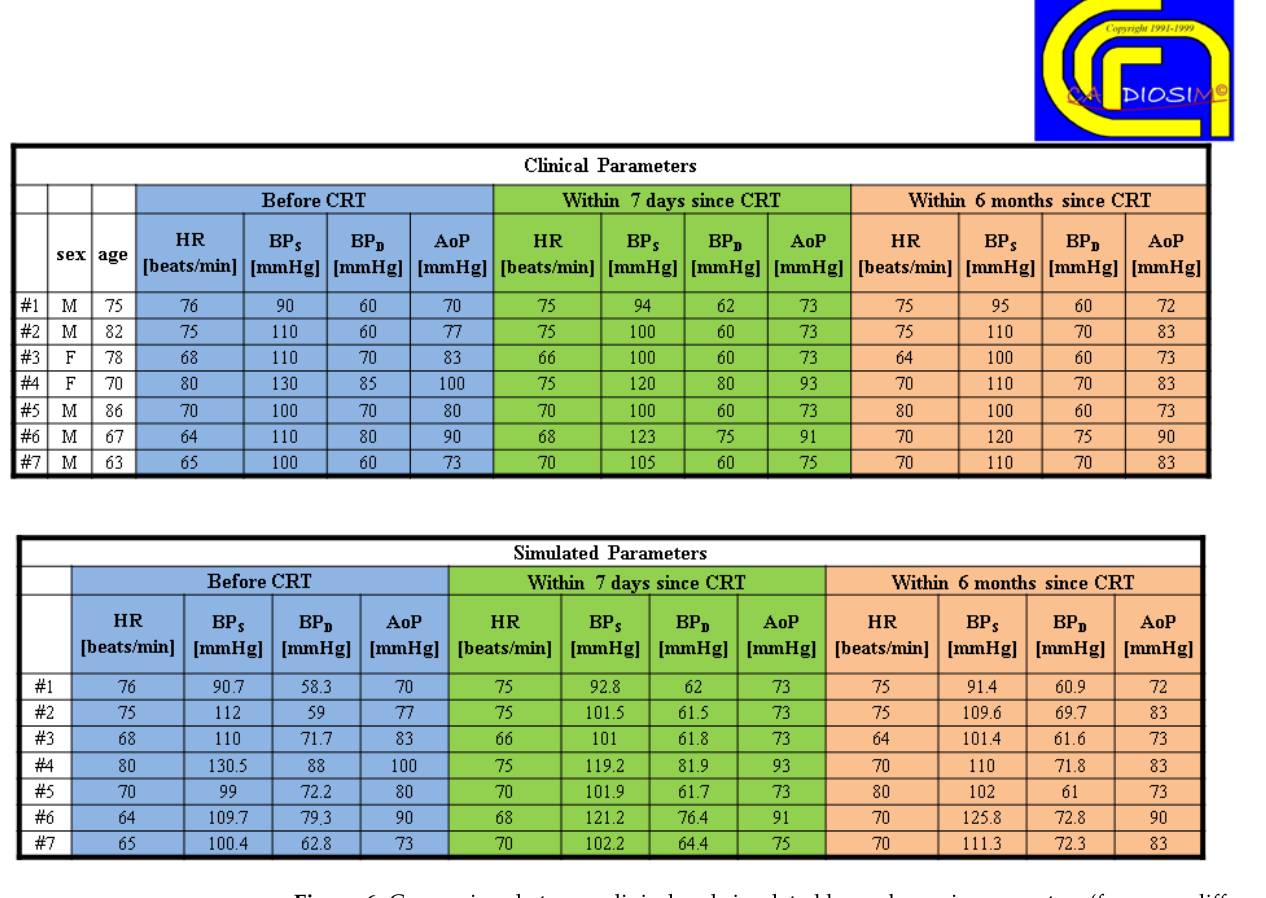
Figure 6. Comparison between clinical and simulated hemodynamic parameters (for seven different patients) before cardiac resynchronization therapy (CRT) and seven days and six months after CRT. (Reprinted with permission from [67], Copyright © 2022–2019 C. De